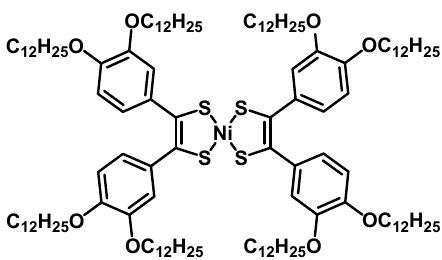
Figure 4. Structure of the selected photothermal agent Ni8C12.